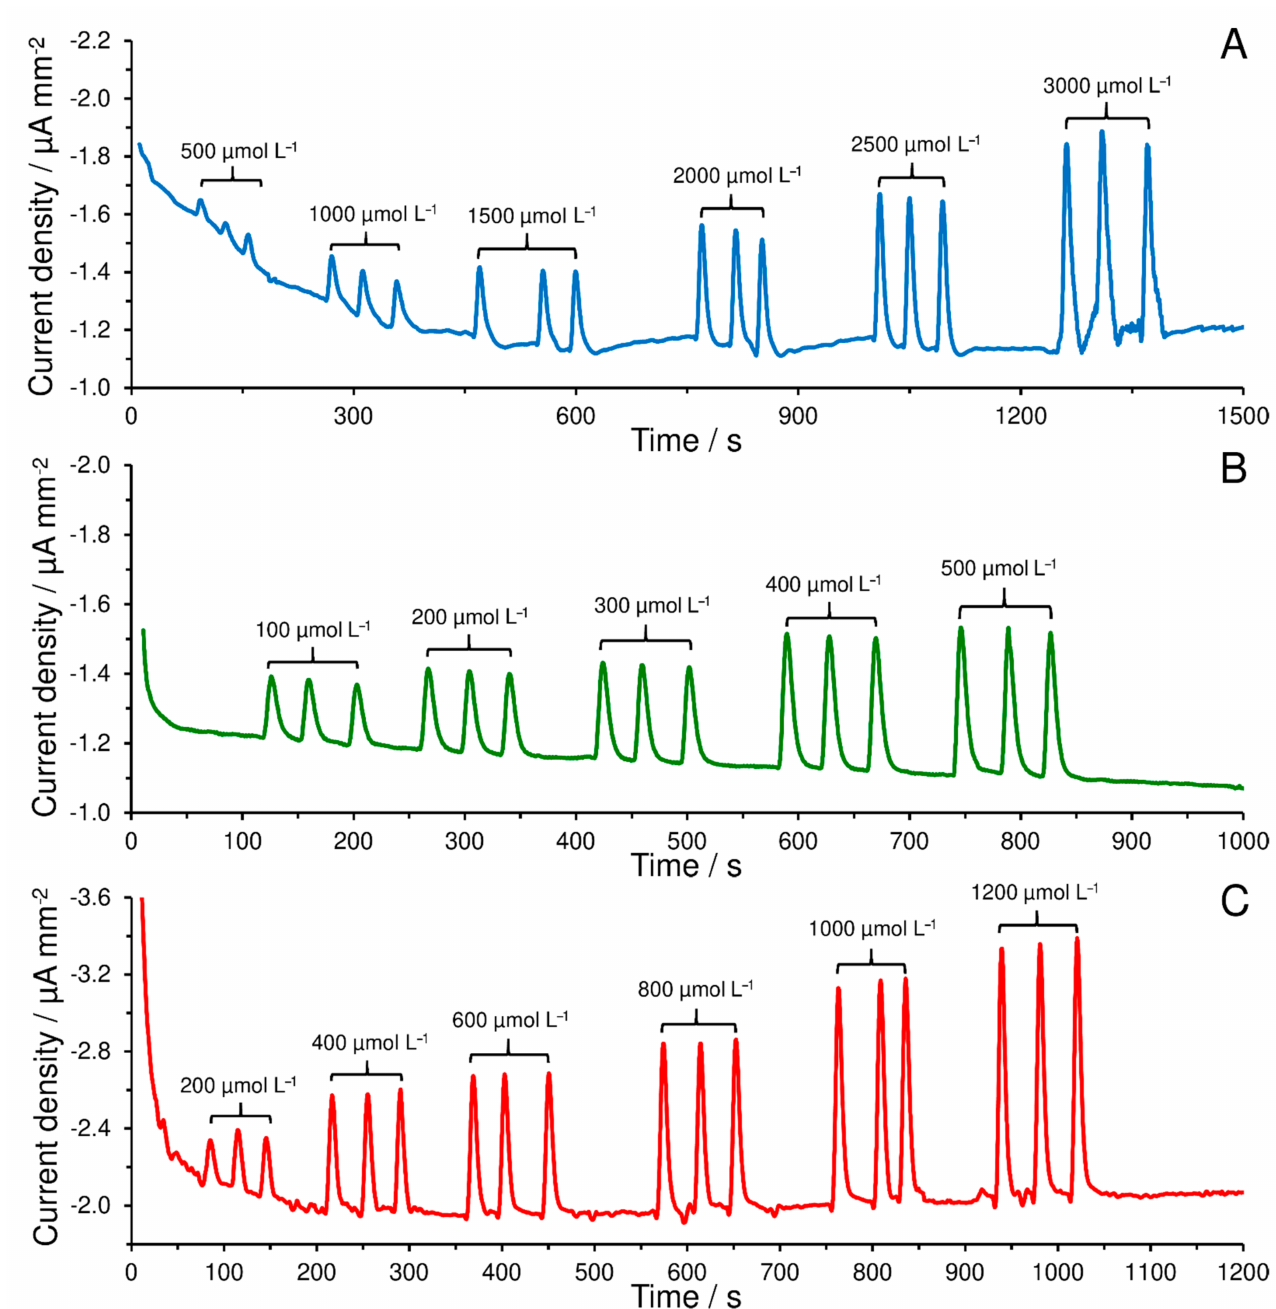
Figure 5. FIA records of H 2 O 2 obtained using SPCE/CBCC-Nafion ® ( A ), SPCE/MWCNTs/CBCC-Nafion ® ( B ), and SPCE/rGO/CBCC-Nafion ® ( C ) at flow rate of 1 mL min − 1 of 0.1 mol L − 1 PB with 0.05 mol L − 1 KCl content (pH 7.0) and applied potential − 0.3